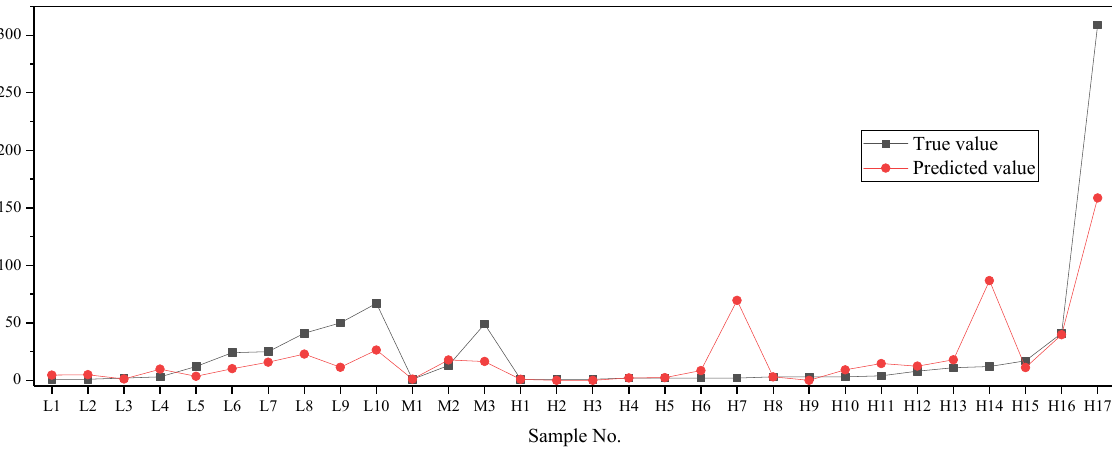
Figure 13. Prediction result of Z-SVR compared with the corresponding true values. Table 6. Representative earthquakes in testing samples.